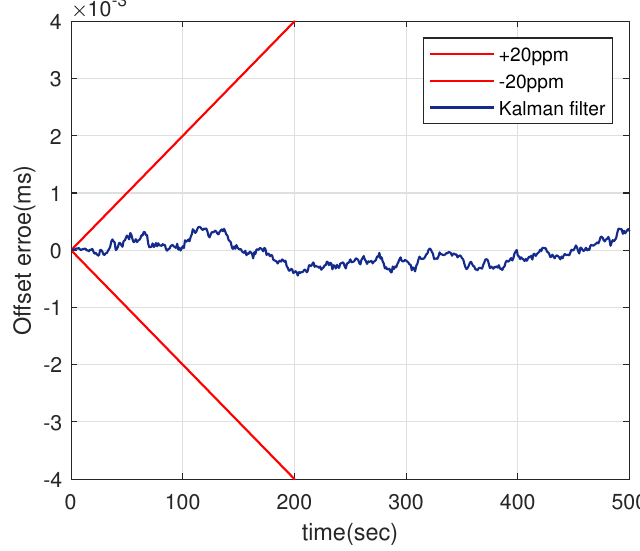
Figure 2. Illustration of clock